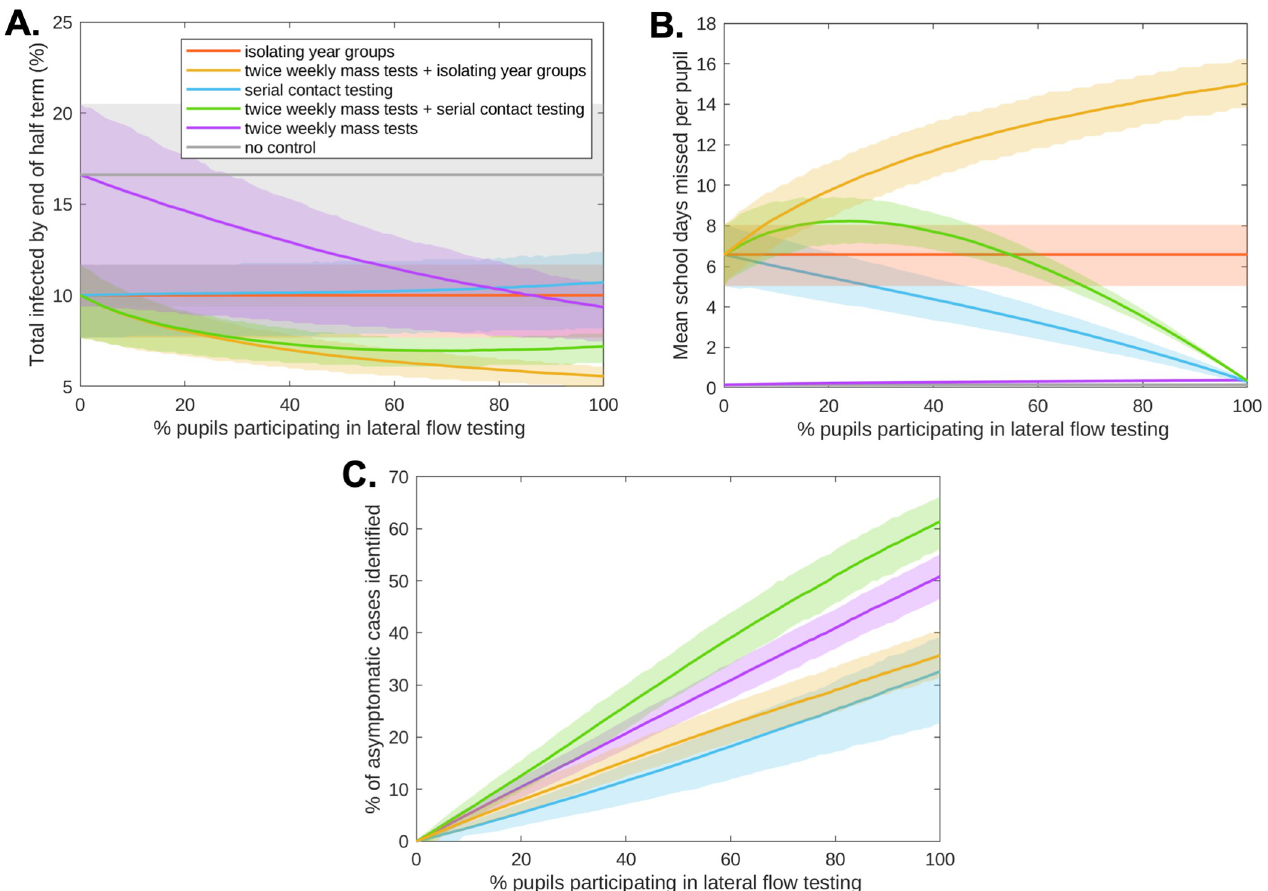
Fig 3. The impact of pupil participation in lateral flow testing on infections and absences. We varied the percentage of pupils who agreed to participate in lateral flow testing (0% to 100%, with 1% increments). (a) Total number of pupils infected by the end of the half-term. (b) Mean school days missed per pupil within a school over the course of the half-term. (c) For rapid testing strategies, the percentage of asymptomatic cases that had been identified through rapid testing by the end of the half term. In each panel, solid line traces correspond to the mean value attained from 2,000 simulations and shaded envelopes represent the 50% prediction intervals (these regions contain 50% of all simulations at each timepoint). The strategies displayed are: no control (grey), twice weekly mass testing (purple), serial contact testing (blue), isolating year group bubbles (orange), combined twice weekly mass testing and serial contact testing (green), combined twice weekly mass testing and isolation of year group bubbles